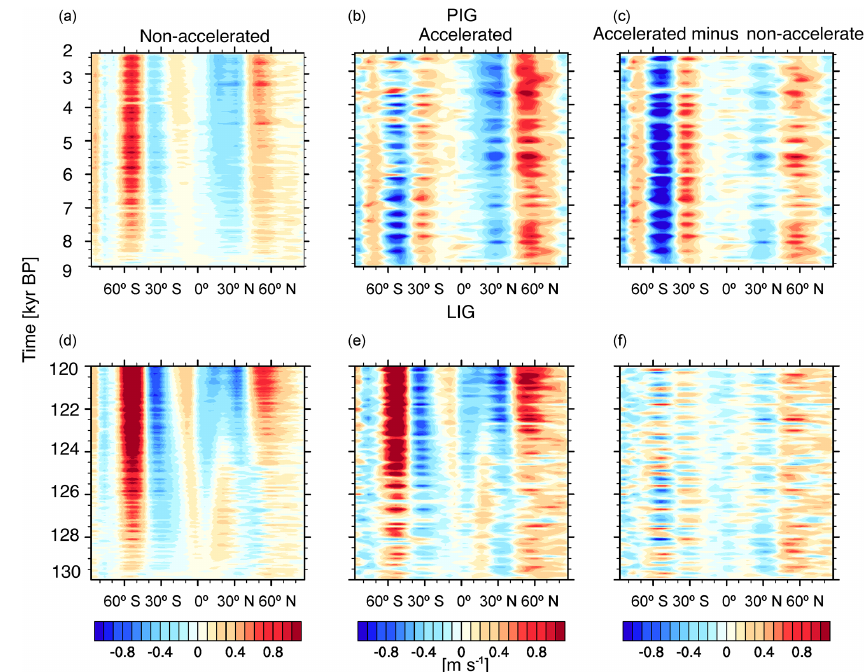
Figure 4. Same as Fig. 3 but for 850hPa zonal